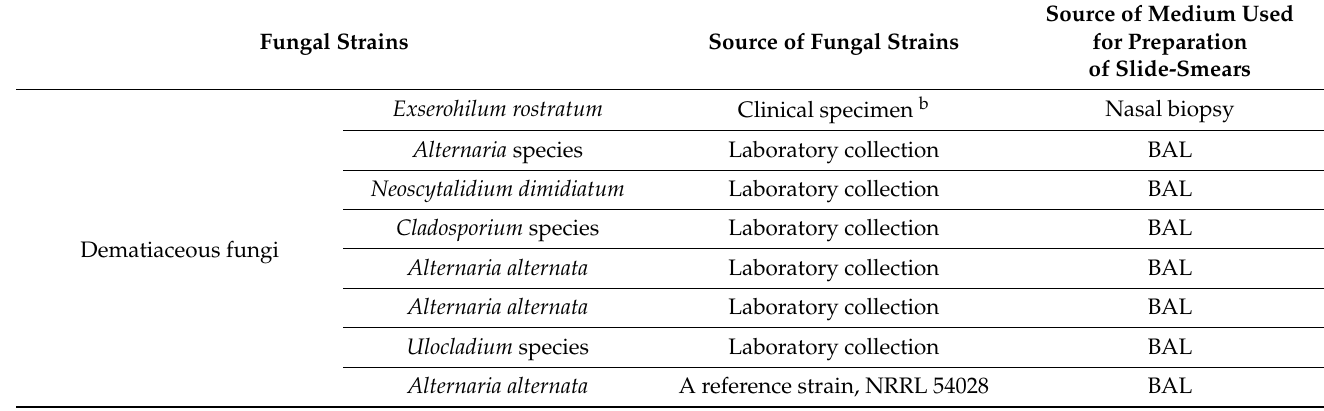
Source of Medium Used